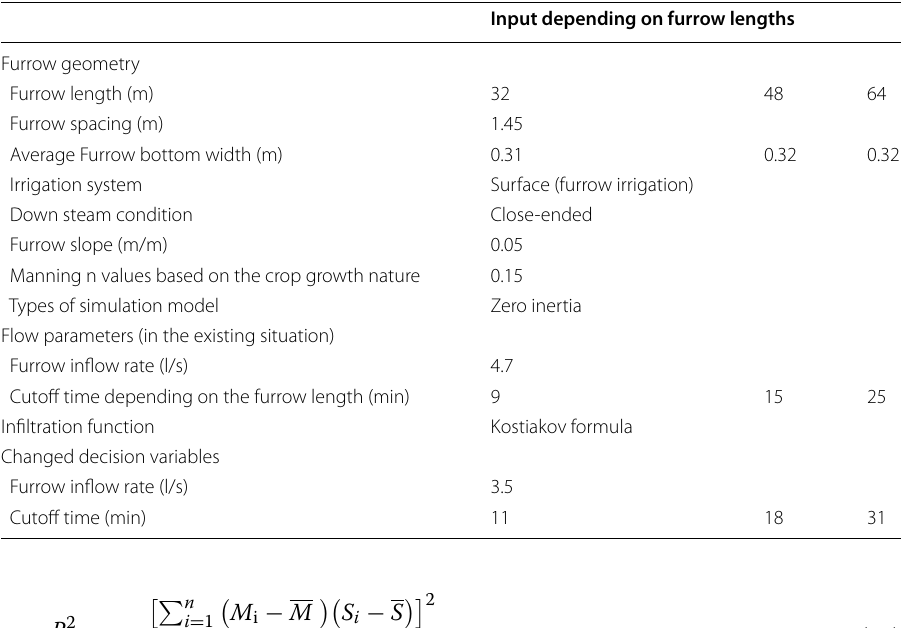
Table 1 Input parameters for the WinSRFR simulation model Input depending on furrow lengths Furrow geometry Furrow length (m) 32 48 64 Furrow spacing (m) 1.45 Average Furrow bottom width (m) 0.31 0.32 0.32 Irrigation system Surface (furrow irrigation) Down steam condition Close-ended Furrow slope (m/m) 0.05 Manning n values based on the crop growth nature 0.15 Types of simulation model Zero inertia Flow parameters (in the existing situation) Furrow inflow rate (l/s) 4.7 Cutoff time depending on the furrow length (min) Infiltration function Kostiakov formula Changed decision variables Furrow inflow rate (l/s) 3.5 Cutoff time